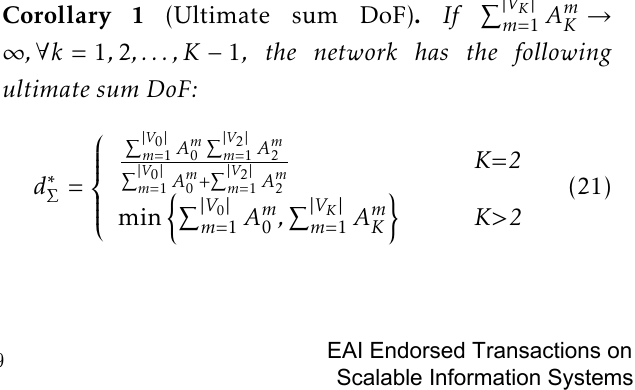
; 4. split, reorganized, and forwarded messages at 1 ; 6. reorganized and forwarded messages at layer R ; 7. received and decoded 2 2